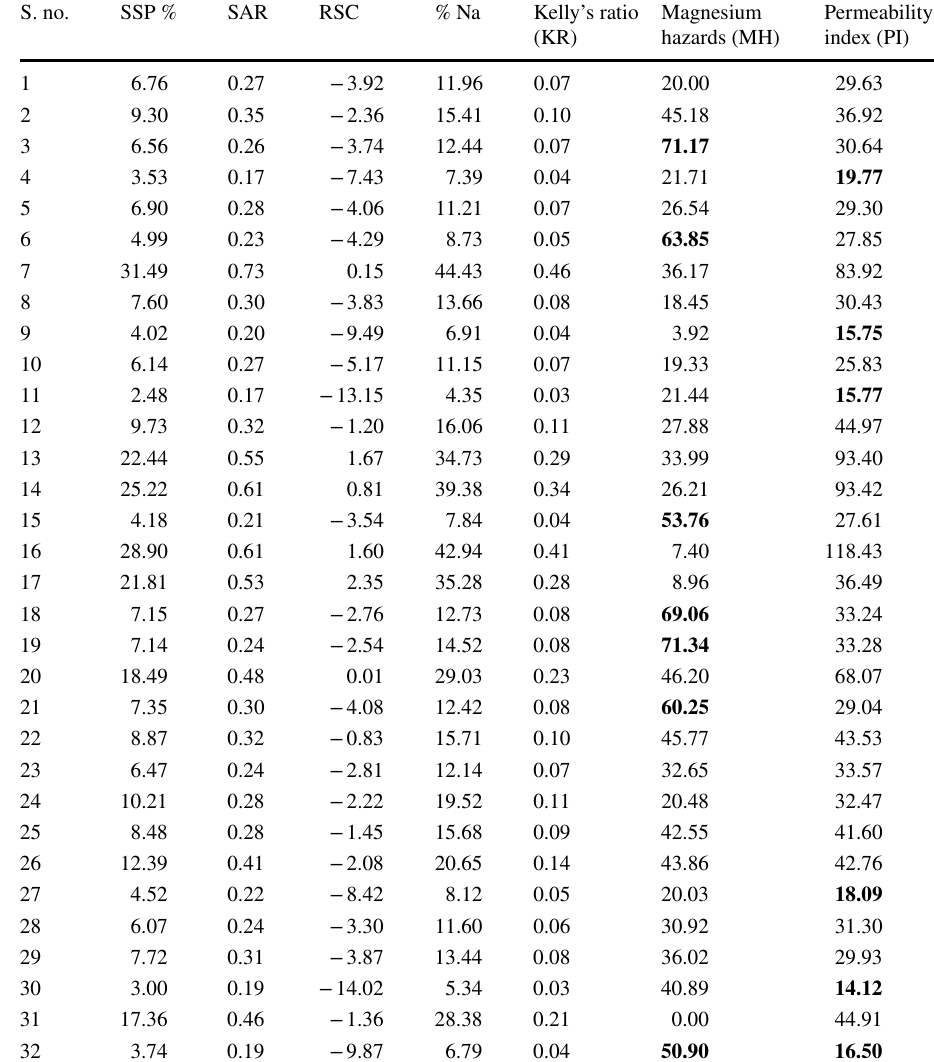
Table 5 Pre-monsoon irrigational suitability of